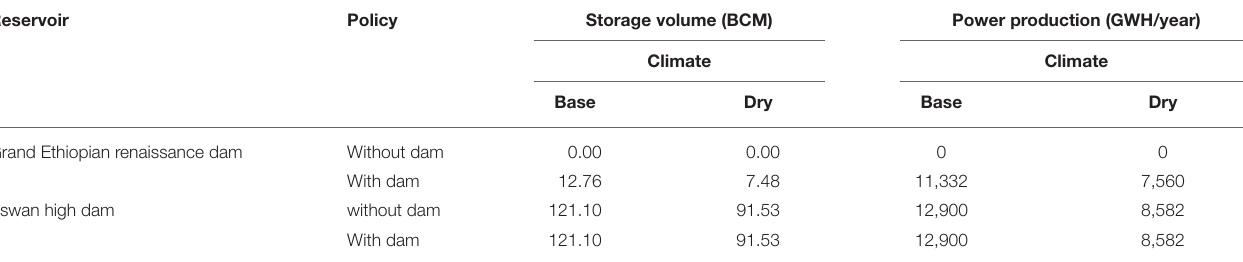
TABLE 3 | Hydroeconomic model results illustration—storage volume and power produced by reservoir, policy and supply scenario, averaged over 20 years, Nile Basin.